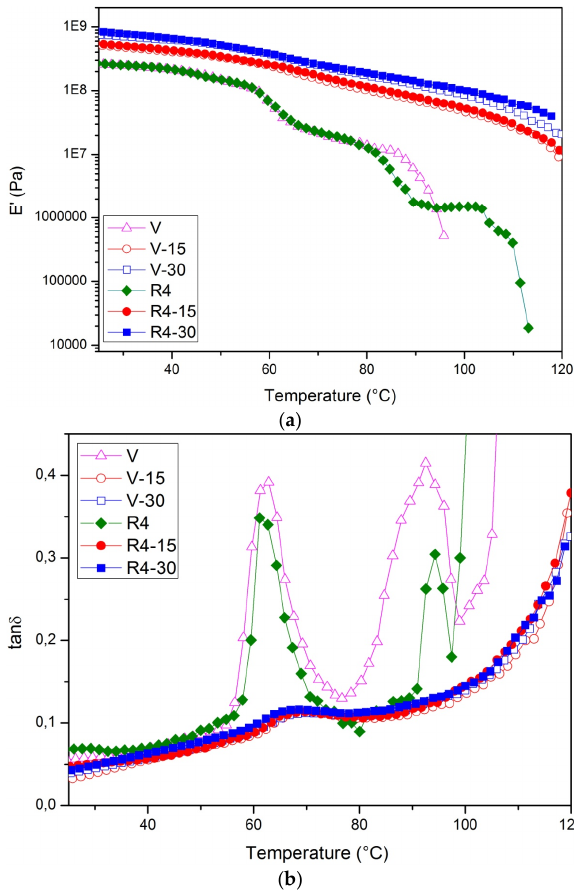
Figure 2. Storage modulus ( a ) and damping factor ( b ) for the investigated samples (V = pristine polymer, R4 = four ‐ times reprocessed polymer, V15 and V30 = 15% and 30% filled composites, R4 ‐ 15 and R4 ‐ 30 = 15% and 30% filled composites prepared with polymer that has been reprocessed four times).